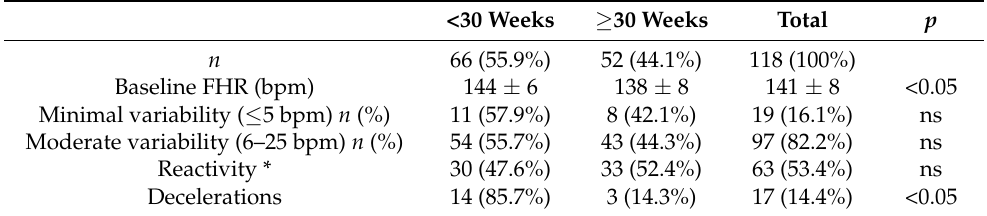
Table 1. Cardiotocographic tracings in 118 preterm fetuses at Virgen de las Nieves University Hospital, Granada,